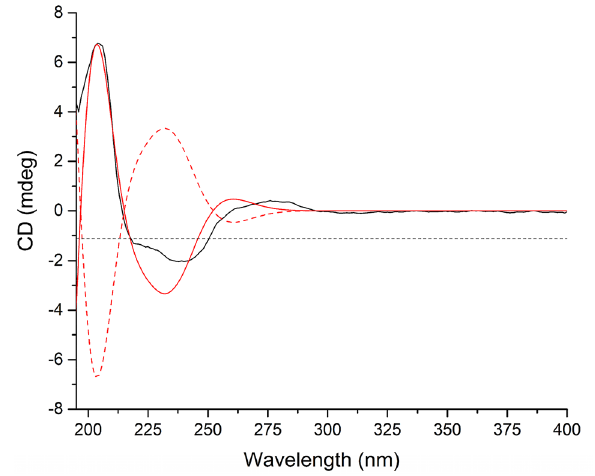
Fig. 4 Experimental ECD spectrum of 2 (black); Calculated ECD spectra of (1 R ,2 R ,4 S ,5 S )- 2 (shift = 12.5 nm, red) and (1 S ,2 S ,4 R ,5 R )- 2 (shift = 12.5 nm, red dash)